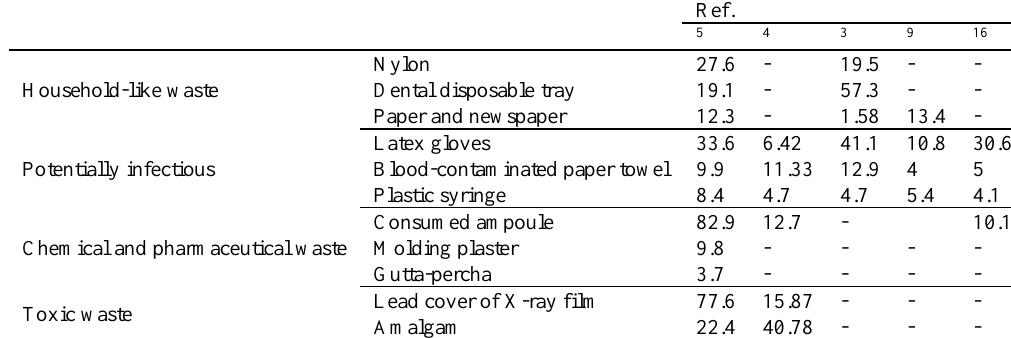
Table 1. Amount and composition of solid waste of dentistry in Iran (O: dental offices, C: dental clinics, Pu: public dental clinics, Pr: private dental clinics) Dentistry Common Infectious Chemical and Location Amount type waste )٪( waste )٪( pharmaceutical waste )٪( Sistan and Pr and Pu Baluchestan C and O Pr, Pu and O Urmia Pr, Pu and C Zabol C Qaem Shahr O Shahroud C Hamadan Pu Birjand C 7848 kg/year Gorgan Pr and Pu 15150 kg/year Yasuj Hamadan O 24598 kg/year Hamadan Pr 2685 kg/year Bojnoord O Babol Babol Pr Table 2. Ratio of various components of dental wastes in some reports (%; *ratio of components to category; #ratio of components to total dental wastes)